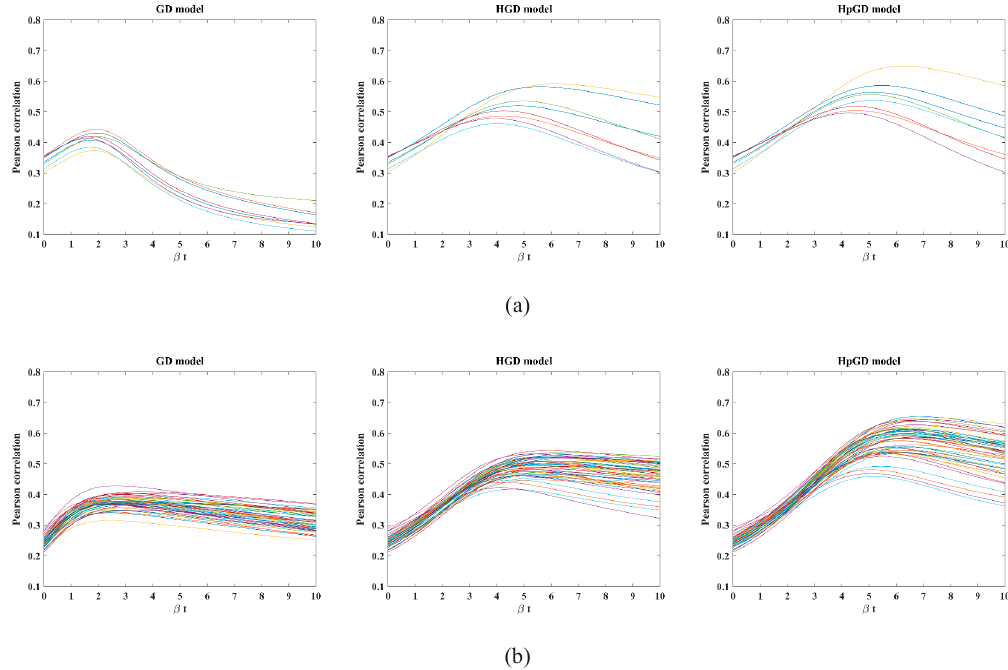
Figure 1. The comparison of the Pearson correlations varying with the parameter β t . ( a ) 90 ROIs dataset ( k = 89, p = 1, Fig. 1 The comparison of the Pearson correlations varying with the parameter β t . (a) 90 ROIs dataset β = − 0.2). ( b ) The 246 ROIs dataset ( k = 245, p = 1.1, β = − 0.2 ).